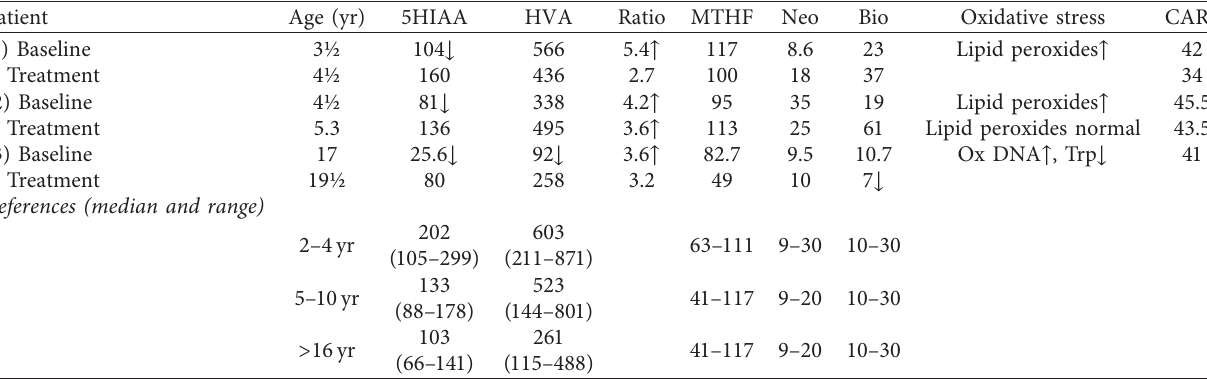
Table 4: CARS and CSF findings at baseline and following antioxidant supplementation during 8 months (patients 1 and 2) and during 2 years (patient 3) among three children with severe infantile